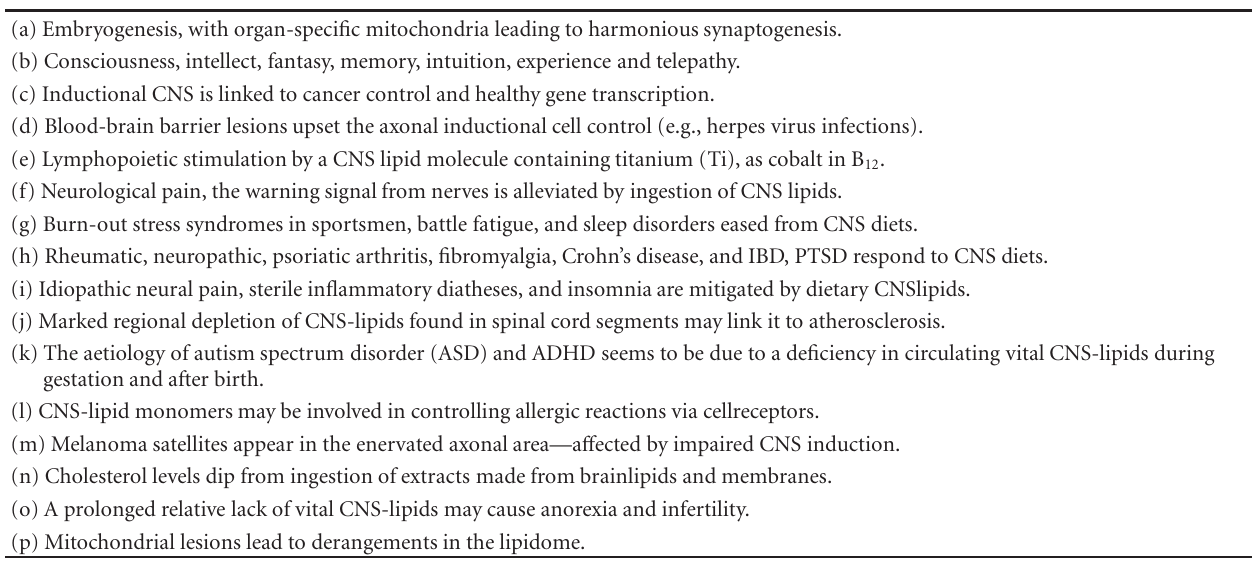
Table 1: Lipidomics, the function of billions of vital lipid molecules forming our brain and spinal cord.